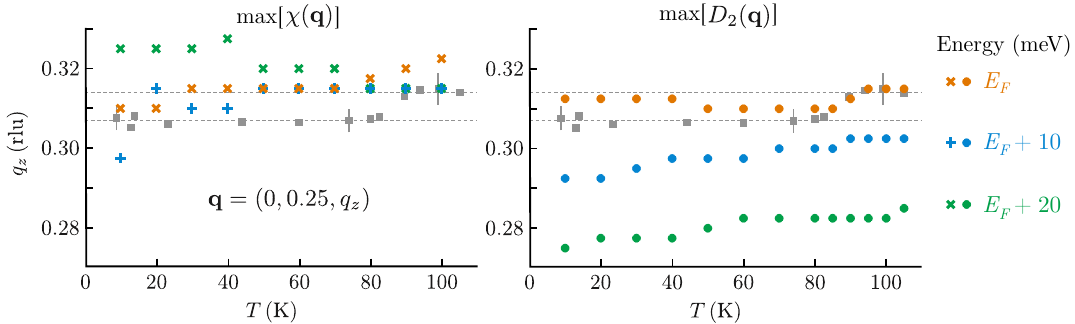
Figure 7: The temperature dependence of the maxima of the Lindhard function χ ) , varying the chemical and structured susceptibility D along the line q = ( 0,0.25, q z 2 potential. E is the experimentally determined Fermi level, which lies 20 meV below F the zero energy level of the computed ab initio band structure shown in Fig. 1 of the main text. The grey data points indicate the experimentally determined charge = 0.307 c ∗ ordering wave-vectors from [ 21 ] , and the grey dashed lines indicate q z = 0.314 c ∗ . While D and q shows a clear trend in its temperature dependence, χ z 2 does